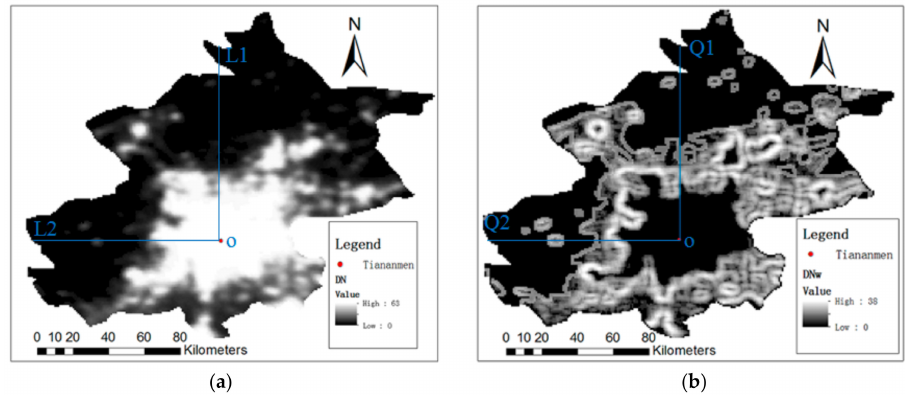
Figure 4. Light intensity ( a ) and degree of light intensity fluctuation ( b